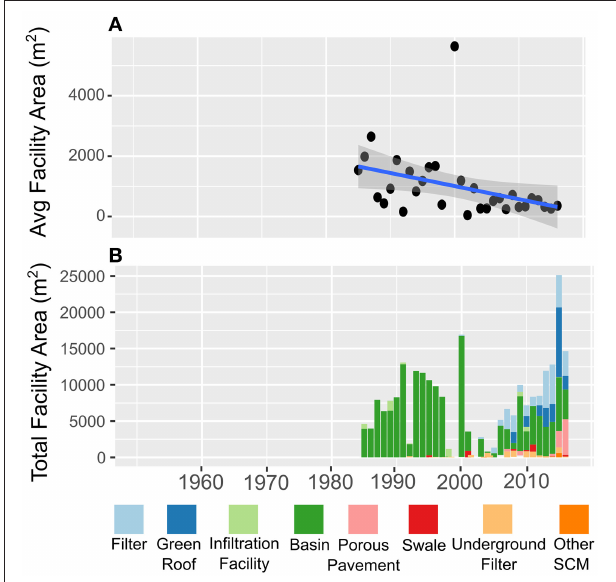
FIGURE 4 | (A) Average area of constructed SCMs for each year of record in Baltimore, with a linear model and 95% confidence intervals indicated and (B) total area of constructed SCMs for each